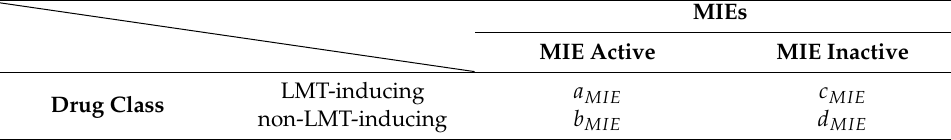
Table 3. Contingency table for calculating reporting odds ratios. a , number of LMT-inducing drugs in MIE active drugs; b , number of non-LMT-inducing drugs in MIE active drugs; c , number of LMT- inducing drugs in MIE inactive drugs; d , number of non-LMT-inducing drugs in MIE inactive